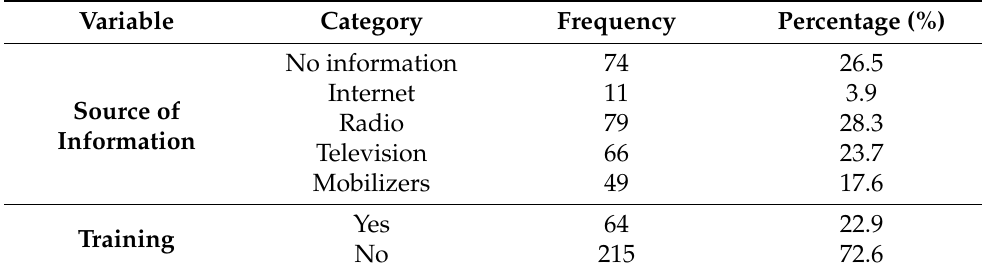
Table 3. Households’ clean cooking (LPG in our case) awareness among participants.